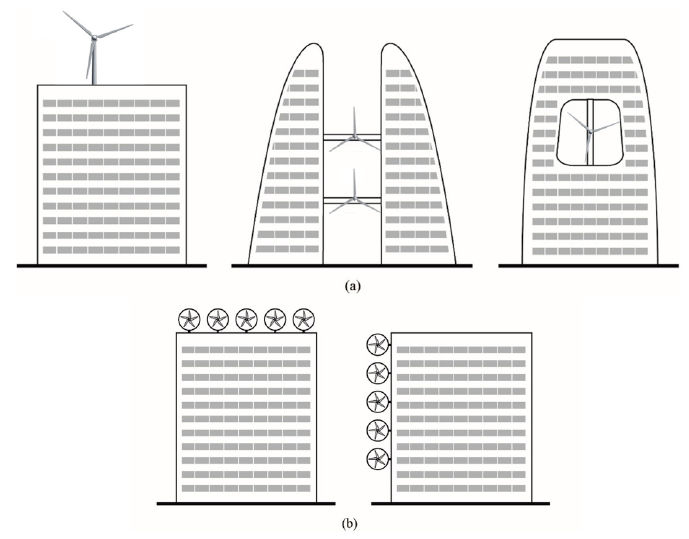
Figure 12. Building integration of ( a ) large scale WTs and ( b ) small scale WTs.